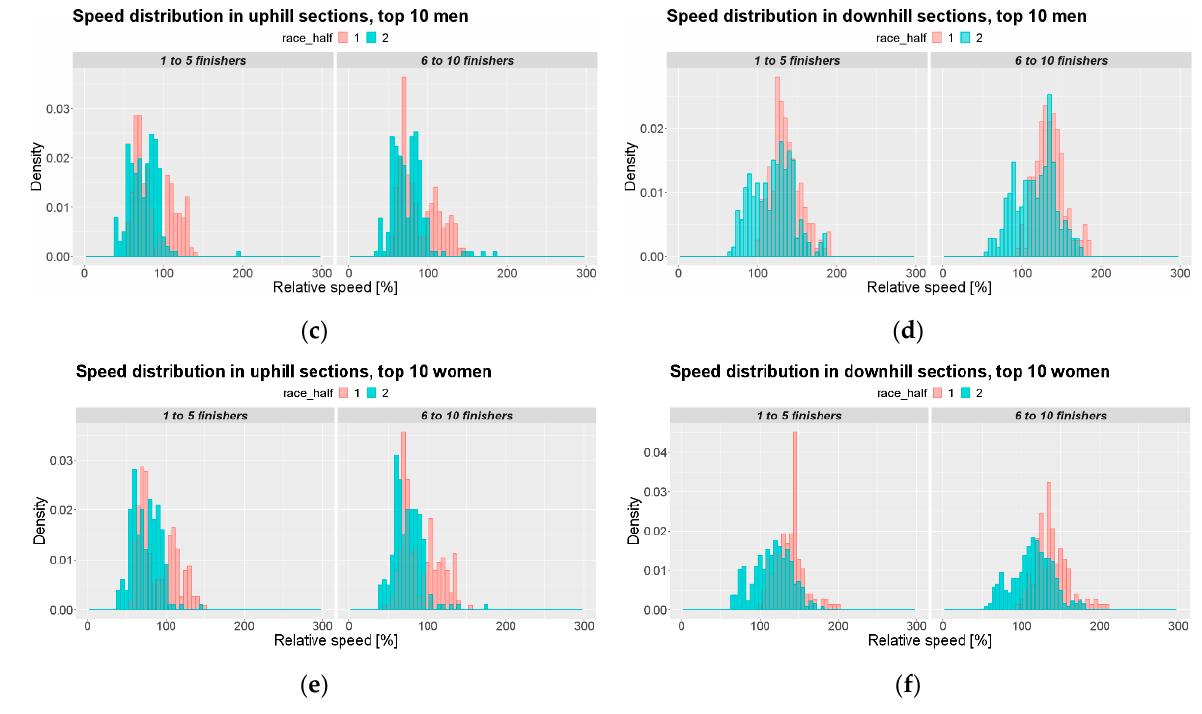
Figure 1. Relative speed section (RSS). Subfigures ( a , b ): full dataset; subfigures ( c , d ): top 10 men of all races; subfigures ( e , f ): top 10 women of all races. Left column: uphill sections; right column: downhill sections.